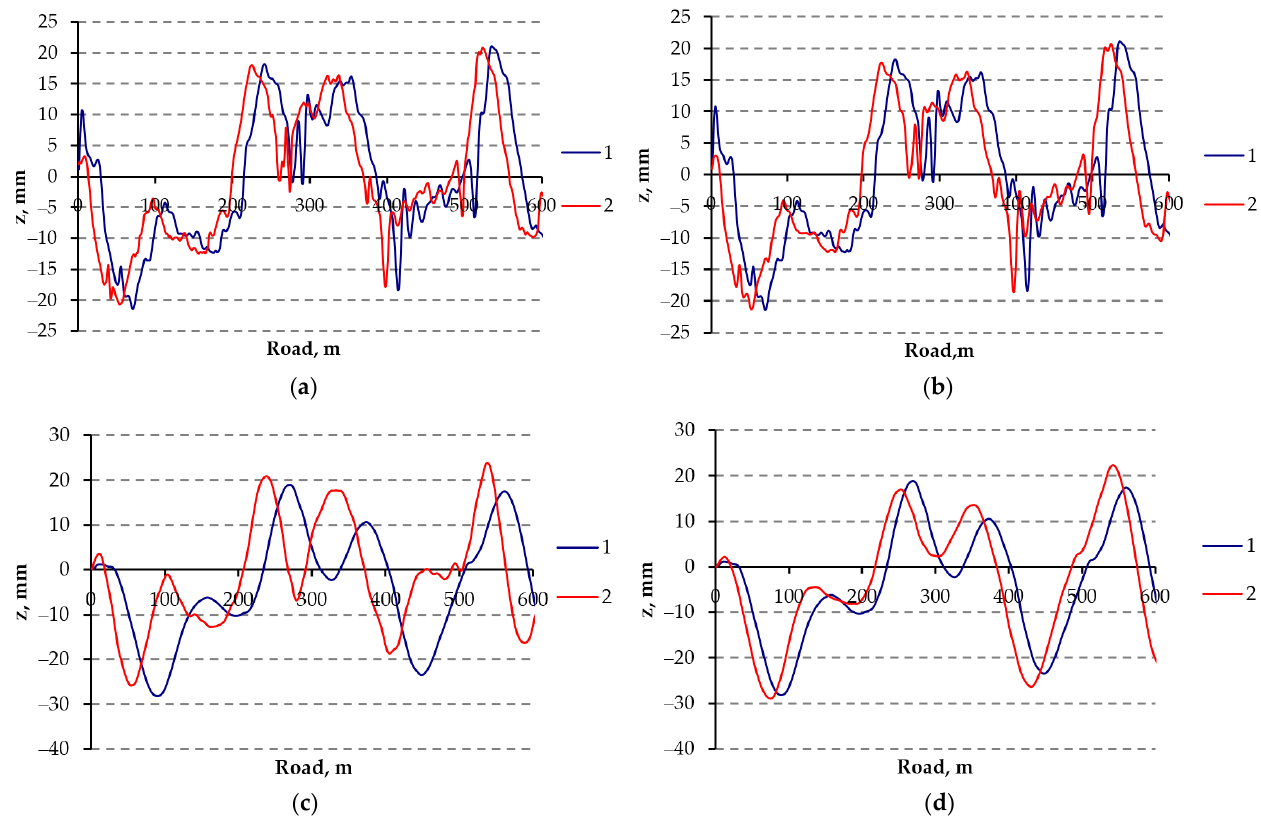
Figure 19. Displacements of unsprung ( a , b ) and sprung ( c , d ) masses (front) of the compact car, calculated using the quarter-car and 3D models: 1—quarter-car model; 2—3D model; ( a , c )— v = 40 km/h; and ( b , d )— v = 80 km/h. Table 6. Quarter-car and 3D model element characteristics.